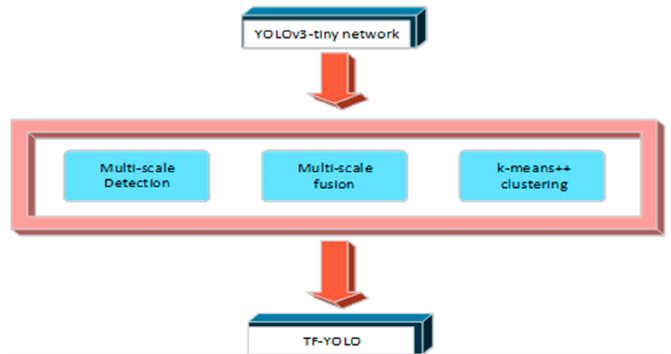
Figure 2. The designed concept of the proposed tiny fast You Only Look Once (TF-YOLO) network. Multi-scale detection is more sensitive to small targets. Multi-scale fusion makes full use of features of the input image. k-means ++ is applied to find more excellent priori boxes of the